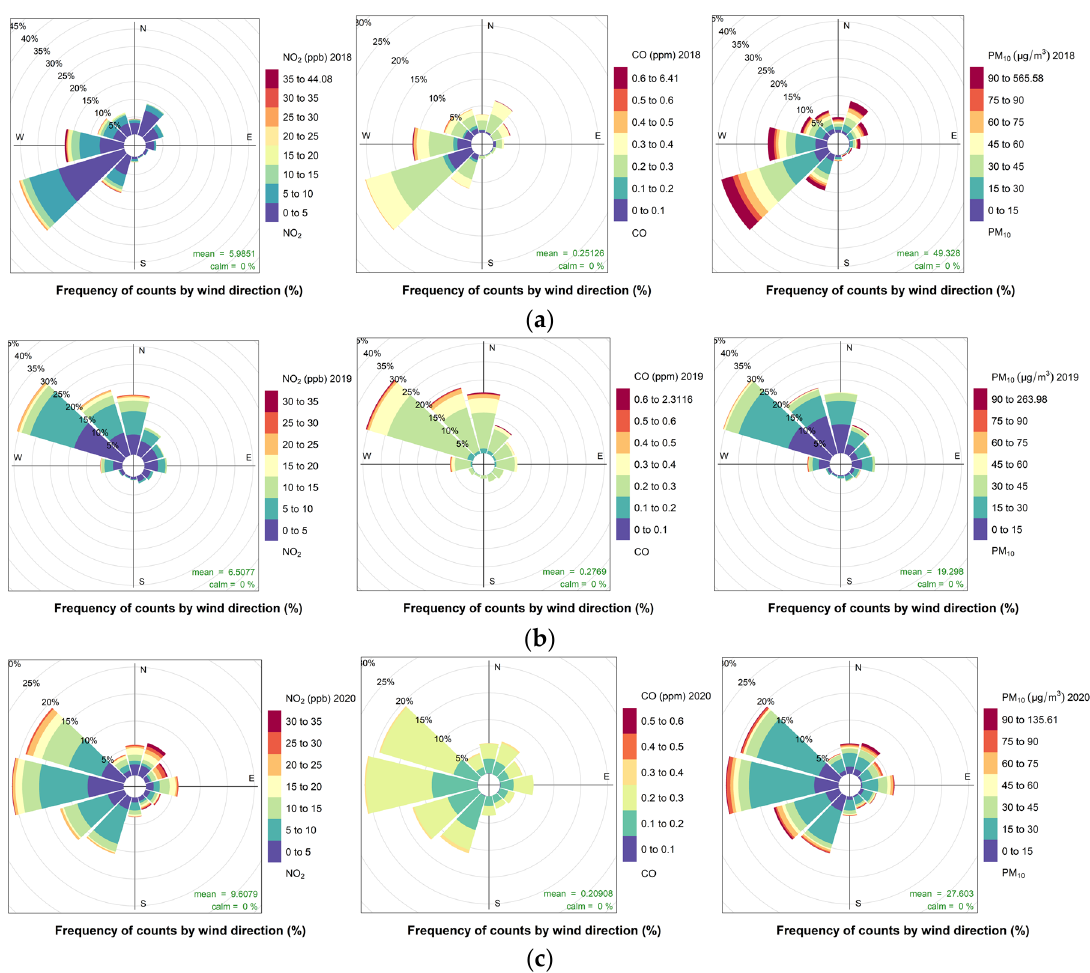
Figure 11. Pollution roses of the three pollutants, NO 2 (left column), CO (centre column) and PM 10 (right column) for the P2 (lockdown) study period in the years of 2018 ( a ), 2019 ( b ) and 2020 ( c ) at the AURA